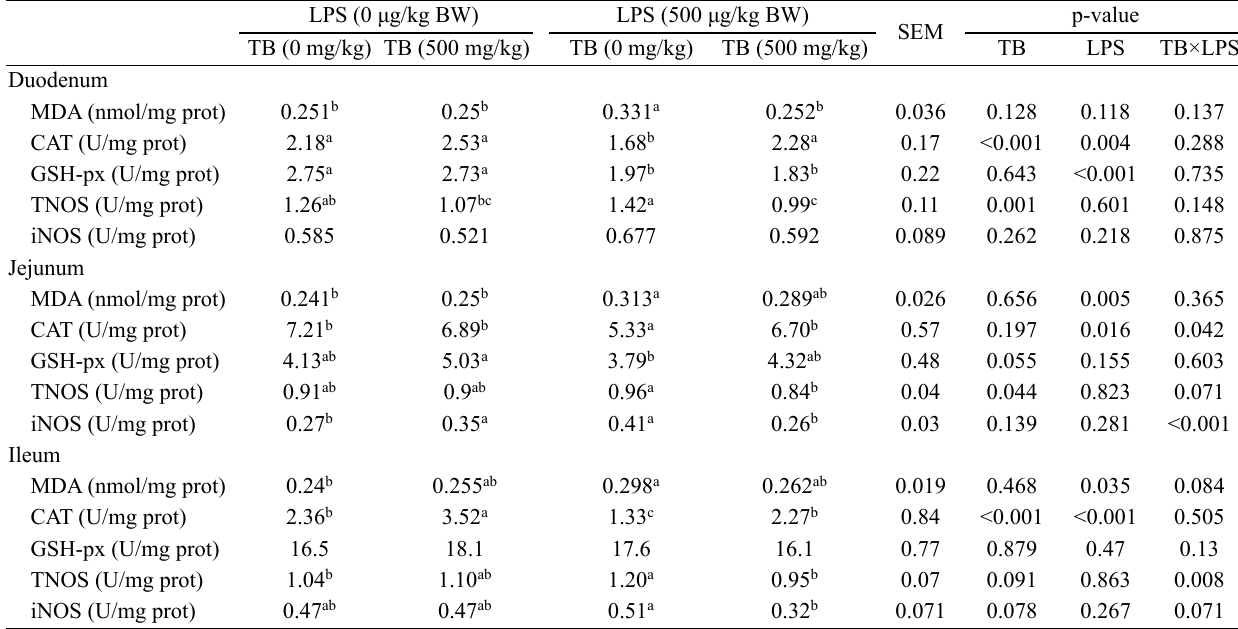
Table 6. Effects of TB on parameters related to intestinal oxidative capacity in LPS-challenged